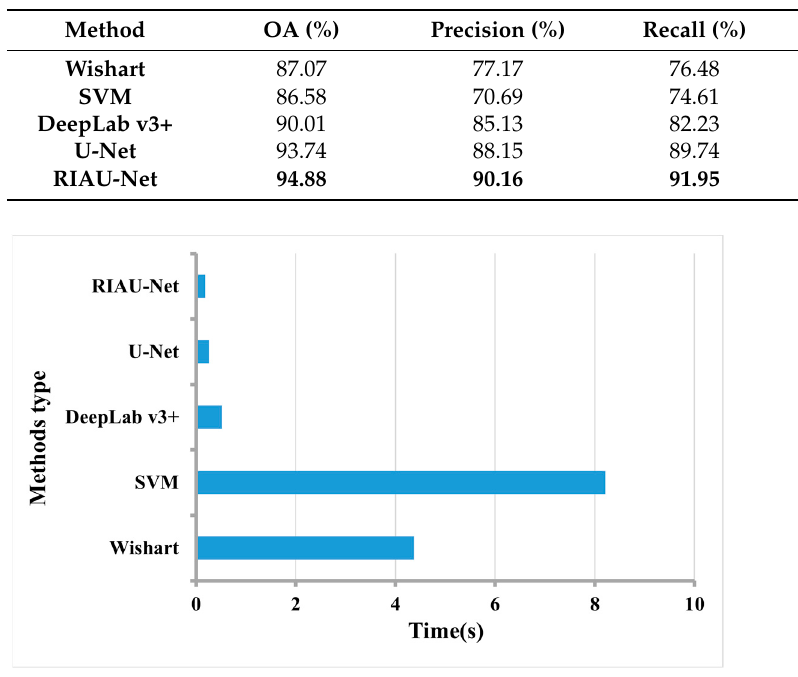
Table 5. Classification results of the different methods.